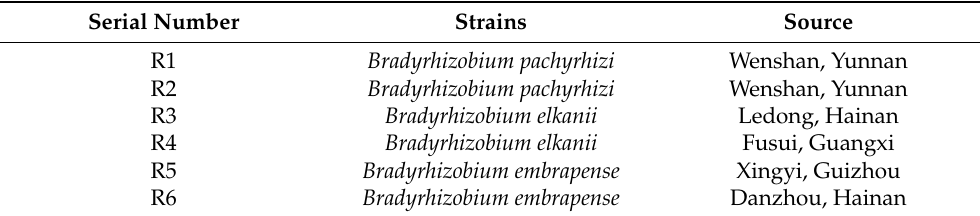
Table 1. Tested rhizobia strains, along with their source and classification status. Serial